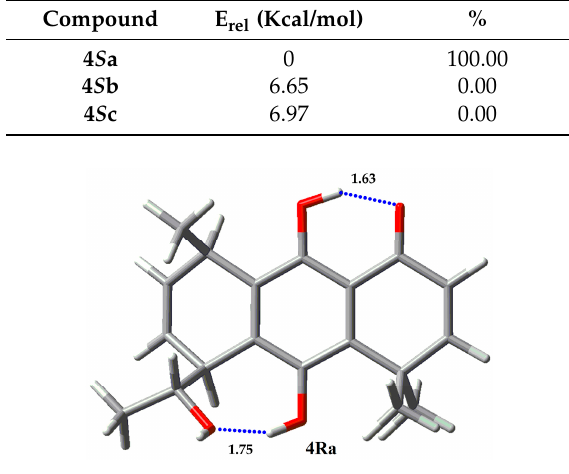
Figure 9. Single rotamer for 4 R . Table 6. Boltzmann population for rotamers of 4 R .